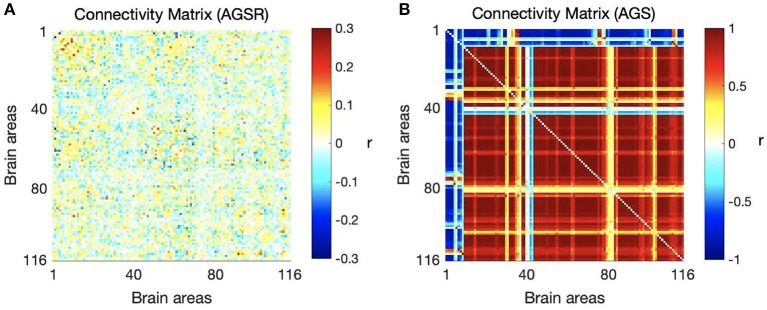
Average functional connectivity matrices of the whole brain regions using AAL 116 atlas over all subjects. (A) Average connectivity matrix of fMRI data applying AGSR which means the connectivity matrix of combination of SIMF1 and SIMF2 including all TIMFs of the fMRI data, (B) connectivity matrix of the AGS which is the combination of SIMF3 to SIMF5 including all TIMFs. AGSR, Adaptive Global Signal regression; AGS, Adaptive Global Signal; SIMF, Spatial Intrinsic Mode Function; TIMF, Temporal Intrinsic Mode Function.